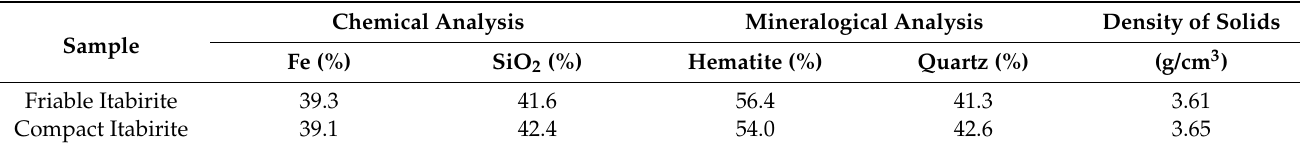
Table 3. Chemical and mineralogical analysis results and actual density of solids.